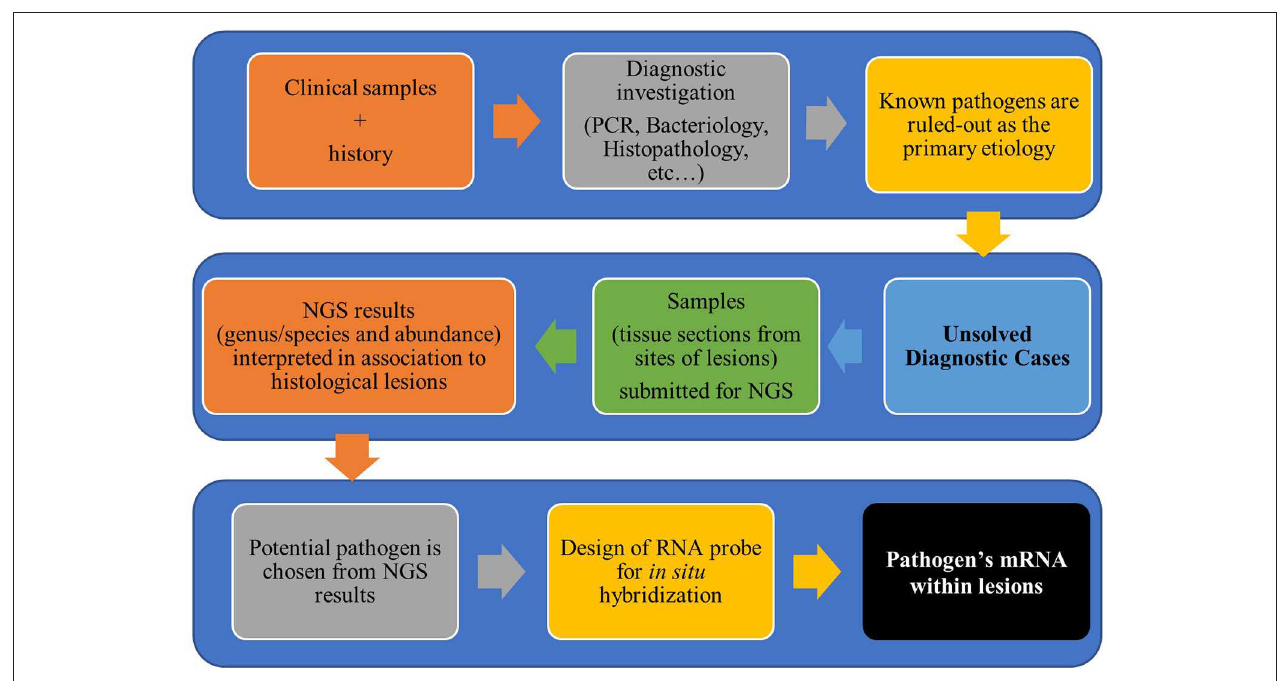
FIGURE 1 | Workflow for diagnostic investigation of unsolved cases using next-generation sequencing and in situ